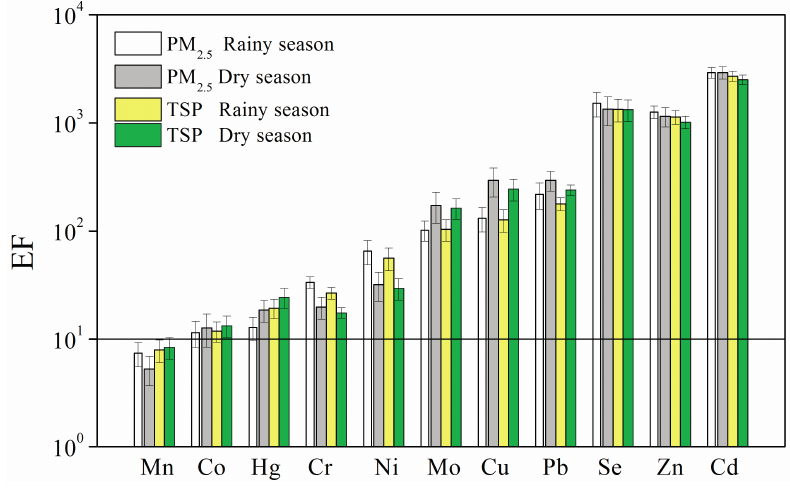
Figure 1. Enrichment factors of the metals in PM seasons. The ANOVA test showed there were no significant differences between the